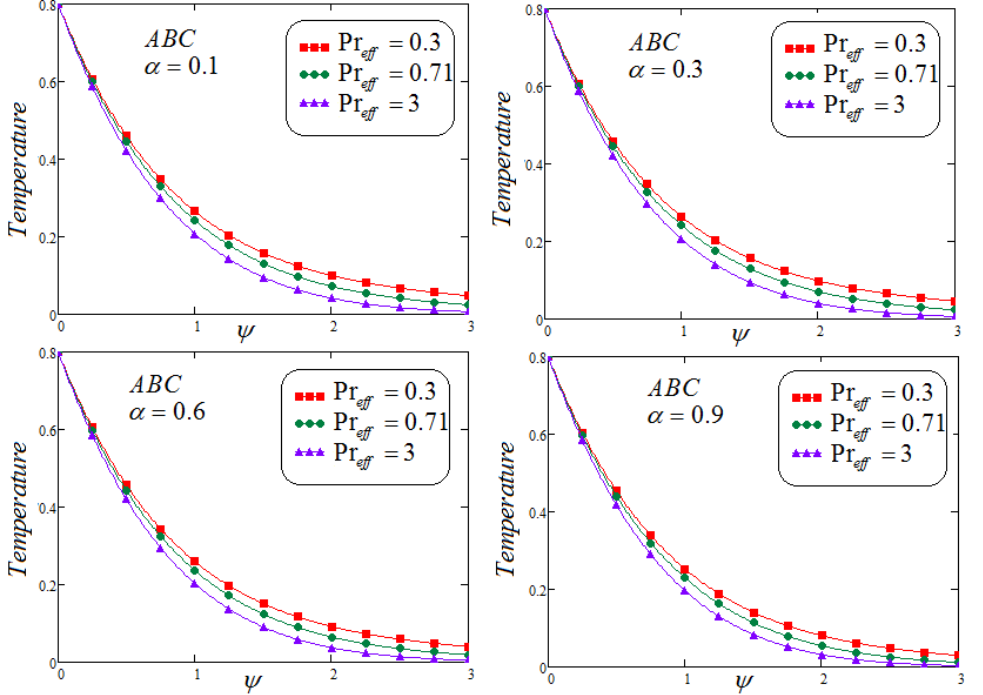
Figure 2. Trace of dimensionless temperature for dissimilar values of Pr ef f via